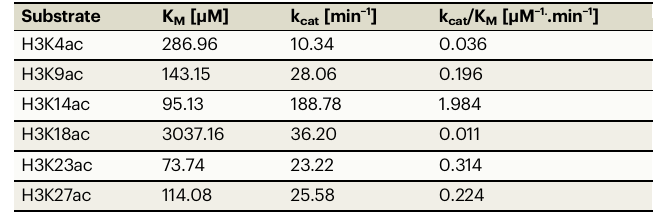
Table 1 | Enzymatic constants of LphD activity against differ- ent acetylated peptides